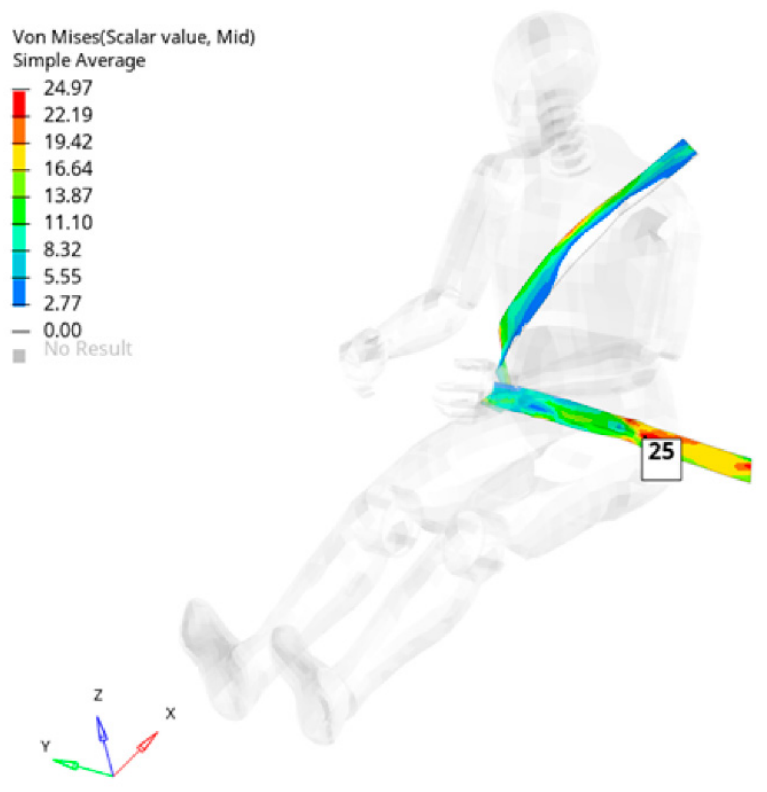
Figure 10. Stress in the belt when T = 0.015 s (in MPa).